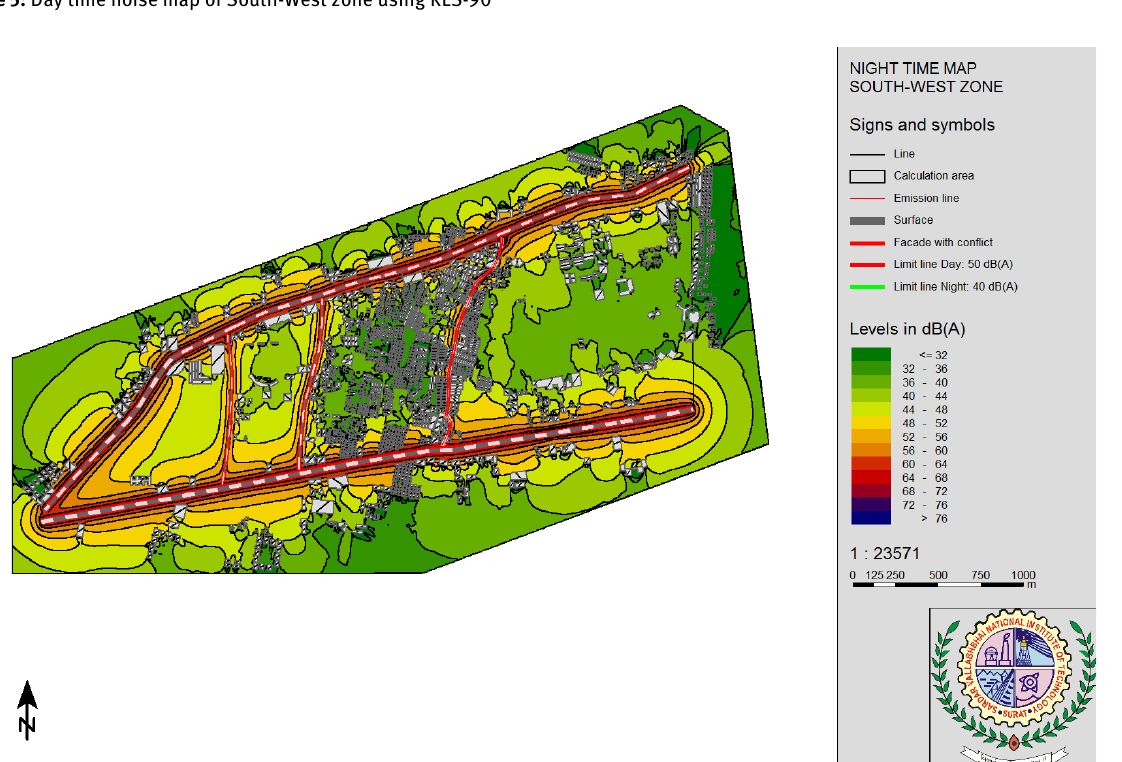
Figure 6: Night time noise map of South-West zone using